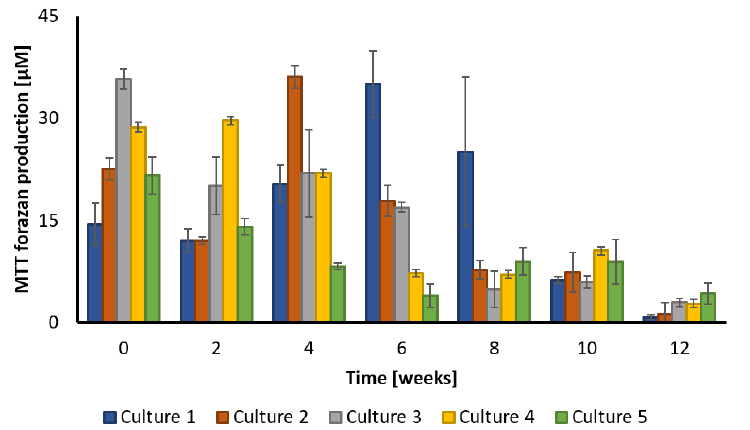
Figure 4. Microbial activity measured by MTT formazan production in different cultures.